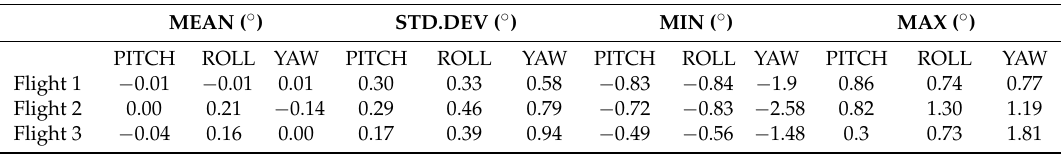
Figure 4. The differences between the indirect (SfM-computed) angles and those from the GPS/INS the photographs of Flight 1. for the photographs of Flight 1. Table 4. Differences after mounting calibration for all three Table 4. Differences after mounting calibration for all three flights.